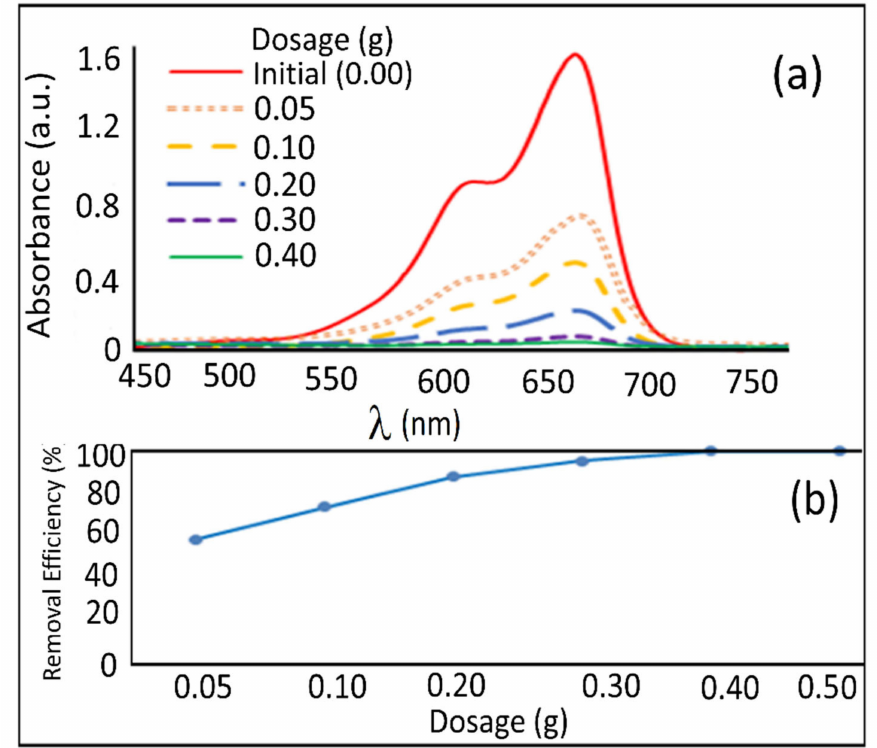
Figure 9. ( a ) UV-visible spectrometer and ( b ) methylene blue elimination effectiveness.